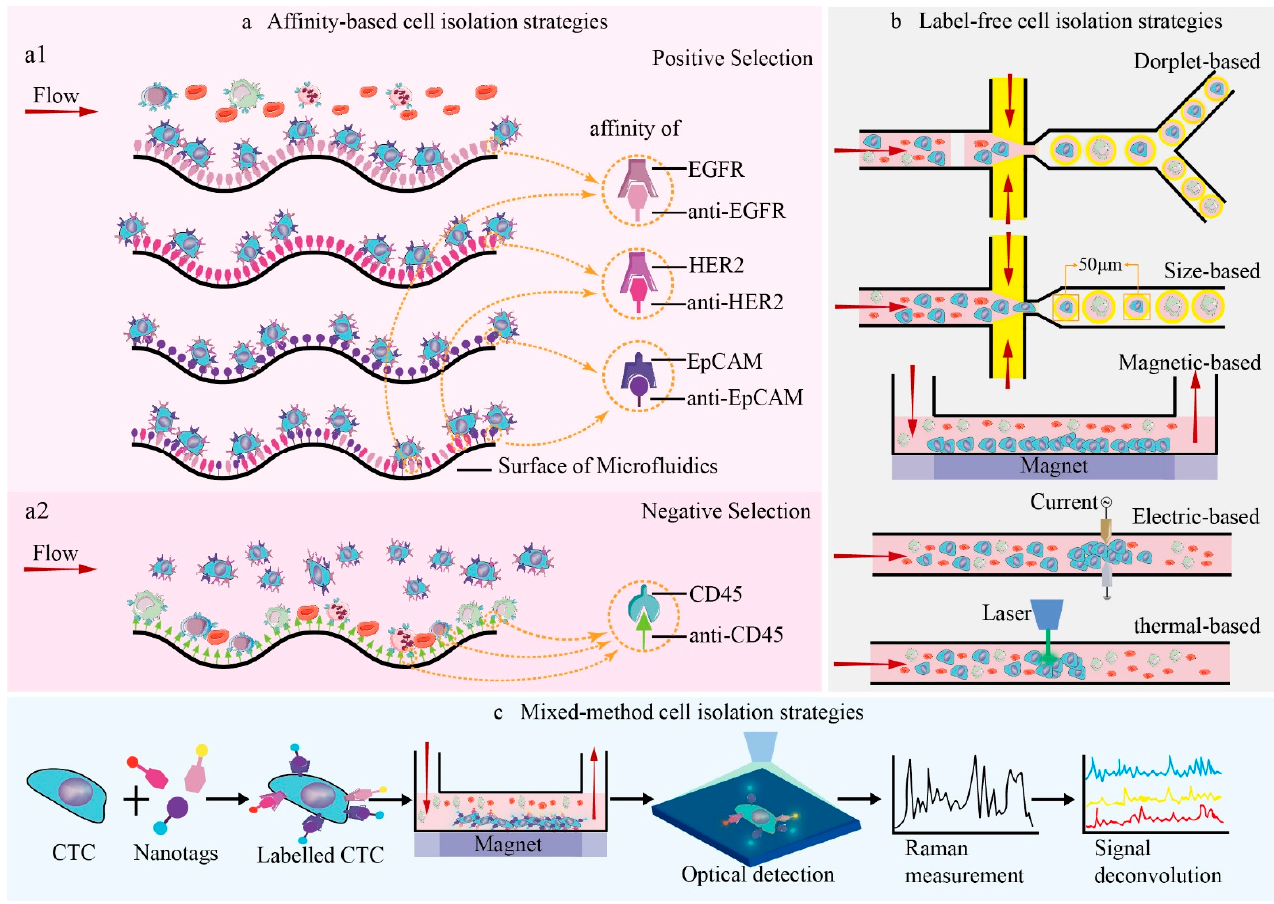
Figure 2. Isolation of tumor cells in microfluidic devices based on biomarkers, label-free methods, and mixed methods. ( a ) Affinity-based cell isolation, ( a1 ) positive selection, ( a2 ) Negative selection. ( b ) Label-free isolation strategies based on different biophysical properties. ( c ) Mixed-method cell isolation strategies based on immunomagnetic isolation and SERS.